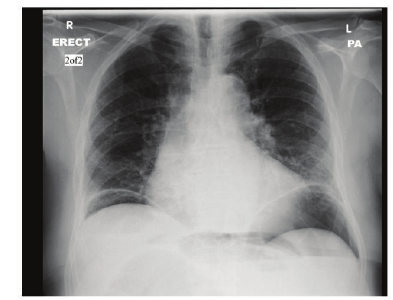
Figure 2: Chest X-ray revealing free intraperitoneal air under the diaphragm.